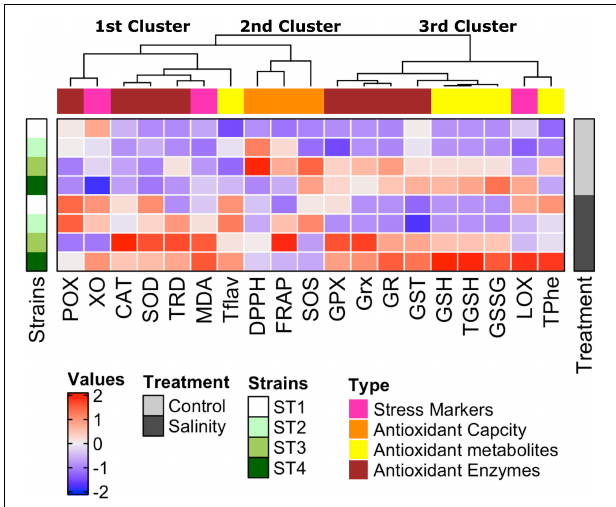
FIGURE 8 | Strain-specific responses of four salt-tolerant bacterial isolates (ST1, ST2, ST3, and ST4) to the stress induced by high salt concentration at both physiological and biochemical levels shown by the hierarchical graph. The measured parameters represented by damage markers, overall antioxidant capacity, antioxidant metabolites, and antioxidant enzymes are grouped into three main clusters based on their response to high salt